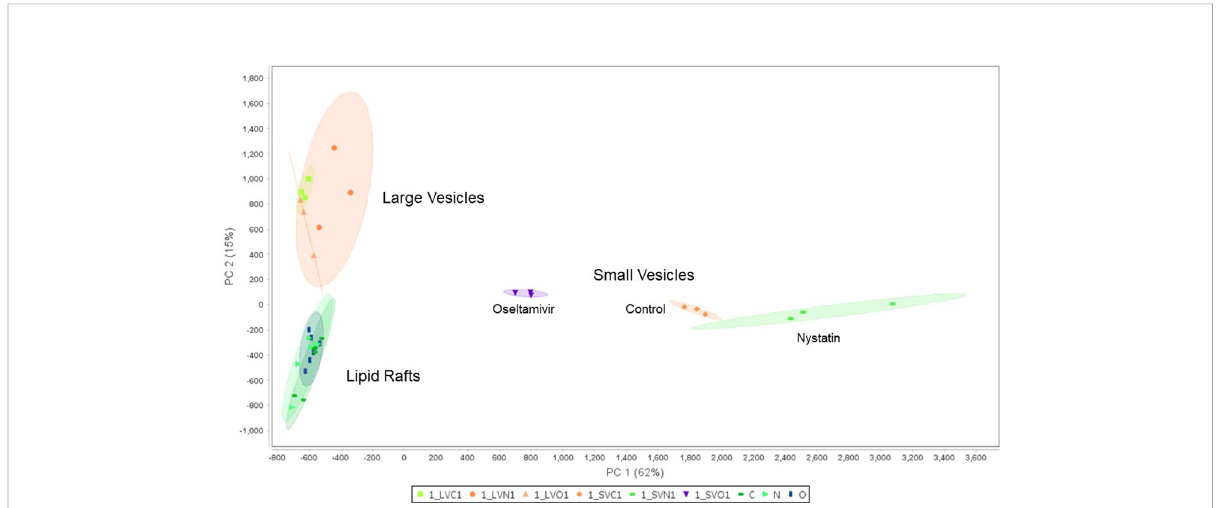
FIGURE 7 Principal component analysis (PCA) of proteomic data between the lipid rafts fractions in the control, nystatin and oseltamivir, the large vesicle fractions in the control, nystatin and oseltamivir, and the small vesicle fraction in the control, nystatin and oseltamivir.